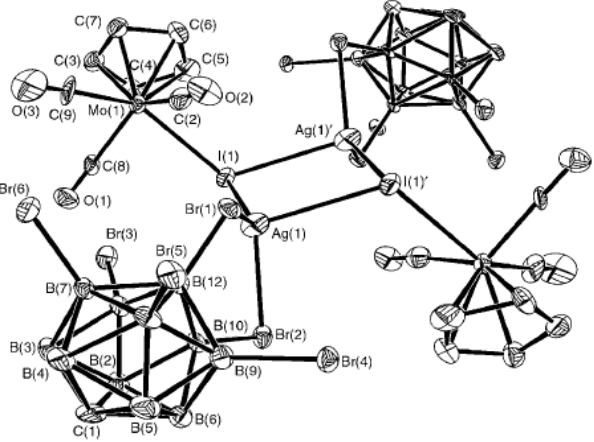
Figure 70. X-ray structure of {[(Cp)Mo(CO) 3 I]Ag[1-CB 11 H 6 -6,7,8,9,10,11,12-Br 6 ]} 2 . Reproduced from reference [88] with permission from The Royal Society of Chemistry.